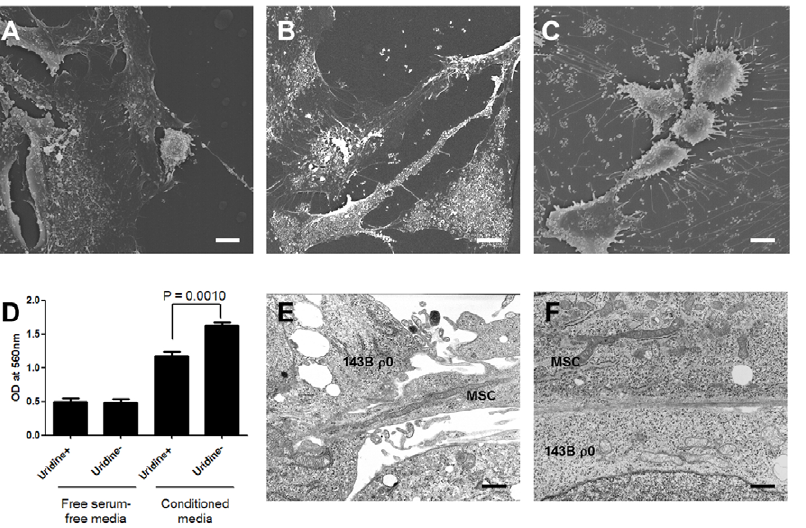
Figure 5. Characteristics of the MSCs in conditioned media from 143B r 0 cells. A scanning electron microscopic examination showed a marked difference in the morphology of the MSCs in each conditioned medium (magnified at 6 1,000; scale bars represent 10 m m). The MSCs in their own growth medium (A); after 24 h (B) and 48 h (C) in conditioned media, which were prepared by treating 143B r 0 cells with uridine-free media for 48 h. The MSCs showed an increased migration in the conditioned media without uridine supplementation (D). A transmission electron microscopic examination was done after two days of Stage I coculture (magnified at 6 9,000; scale bars represent 1 m m). There were intercellular contacts between r 0 and the MSCs by either cytoplasmic process (E) or broad surface contact (F).